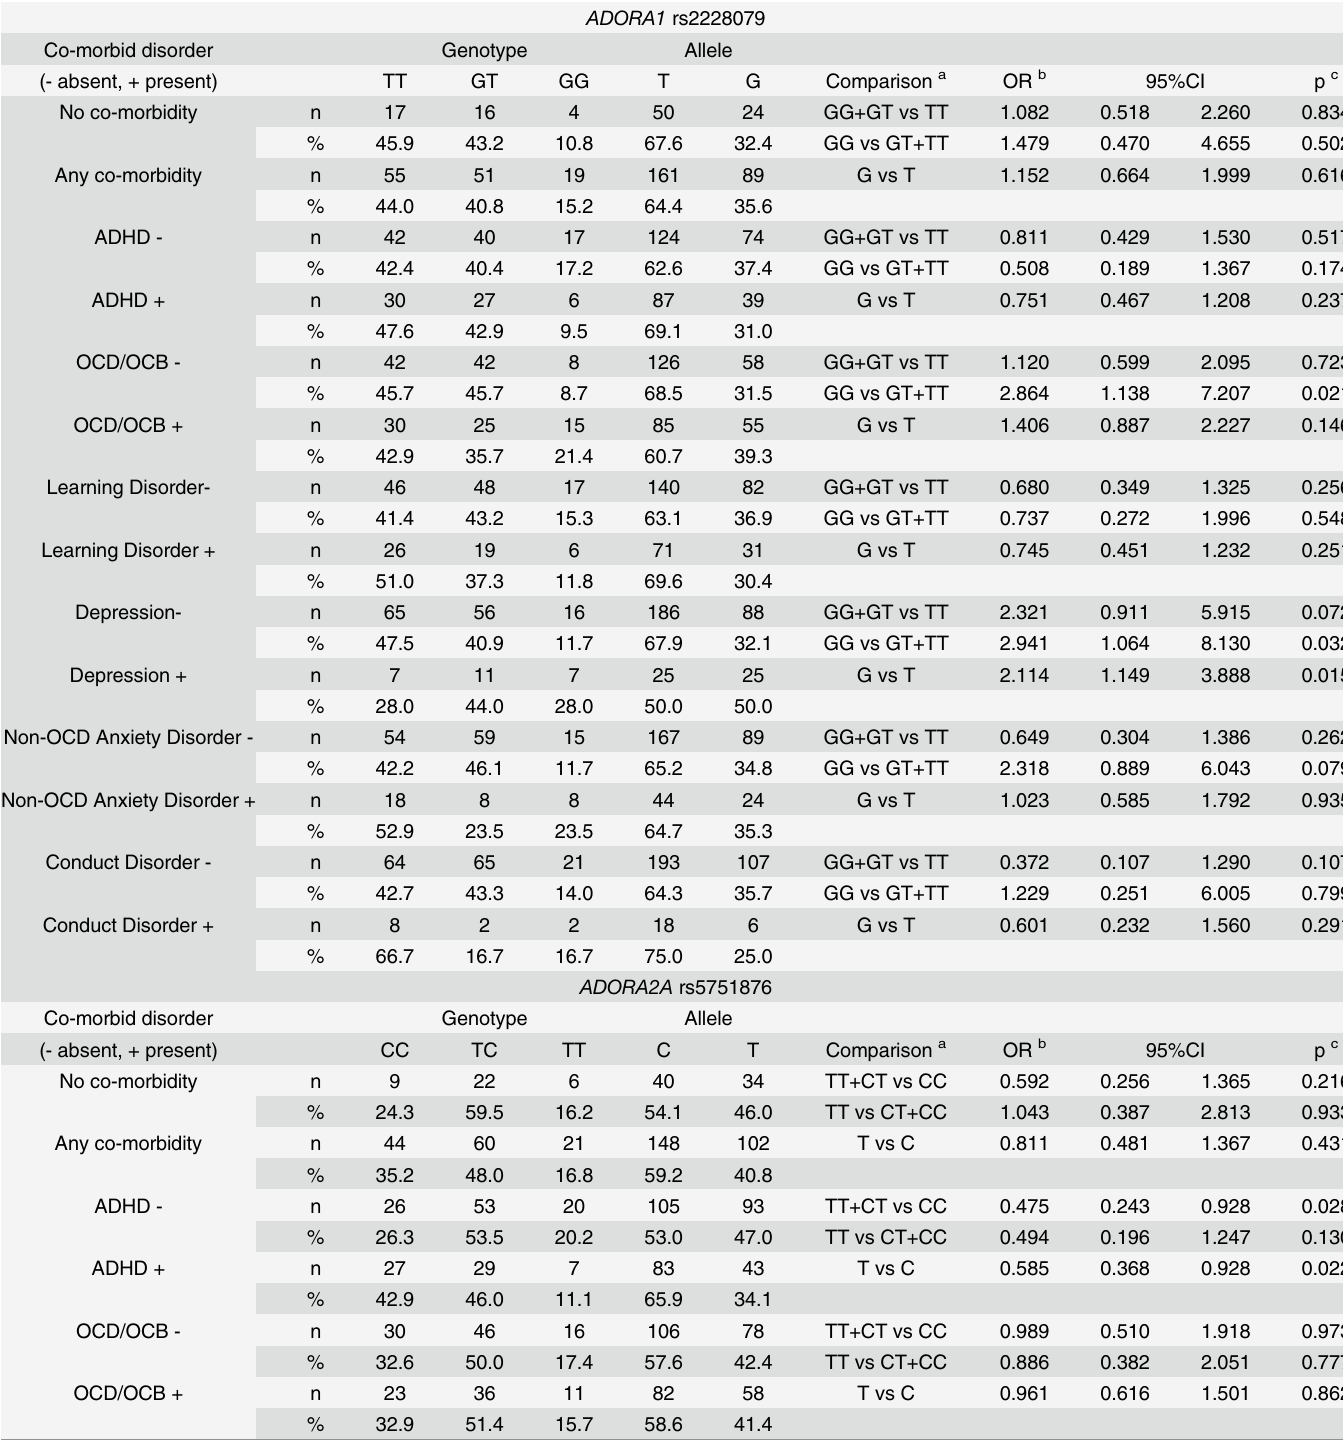
Table 3. Genotypic and allelic association analysis of ADORA1 rs2228079 and ADORA2A rs5751876 variants with co-morbid disorders in patients with Gilles de la Tourette syndrome. ADORA1